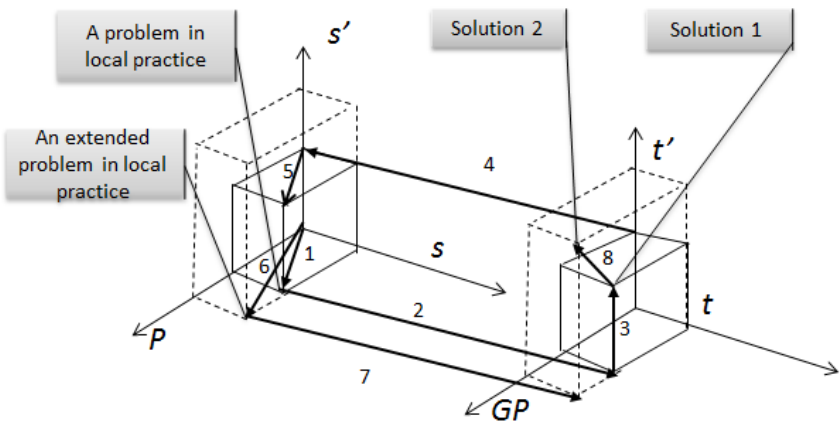
Figure 7. Project 2 – trajectory of movements inside and between the two worlds